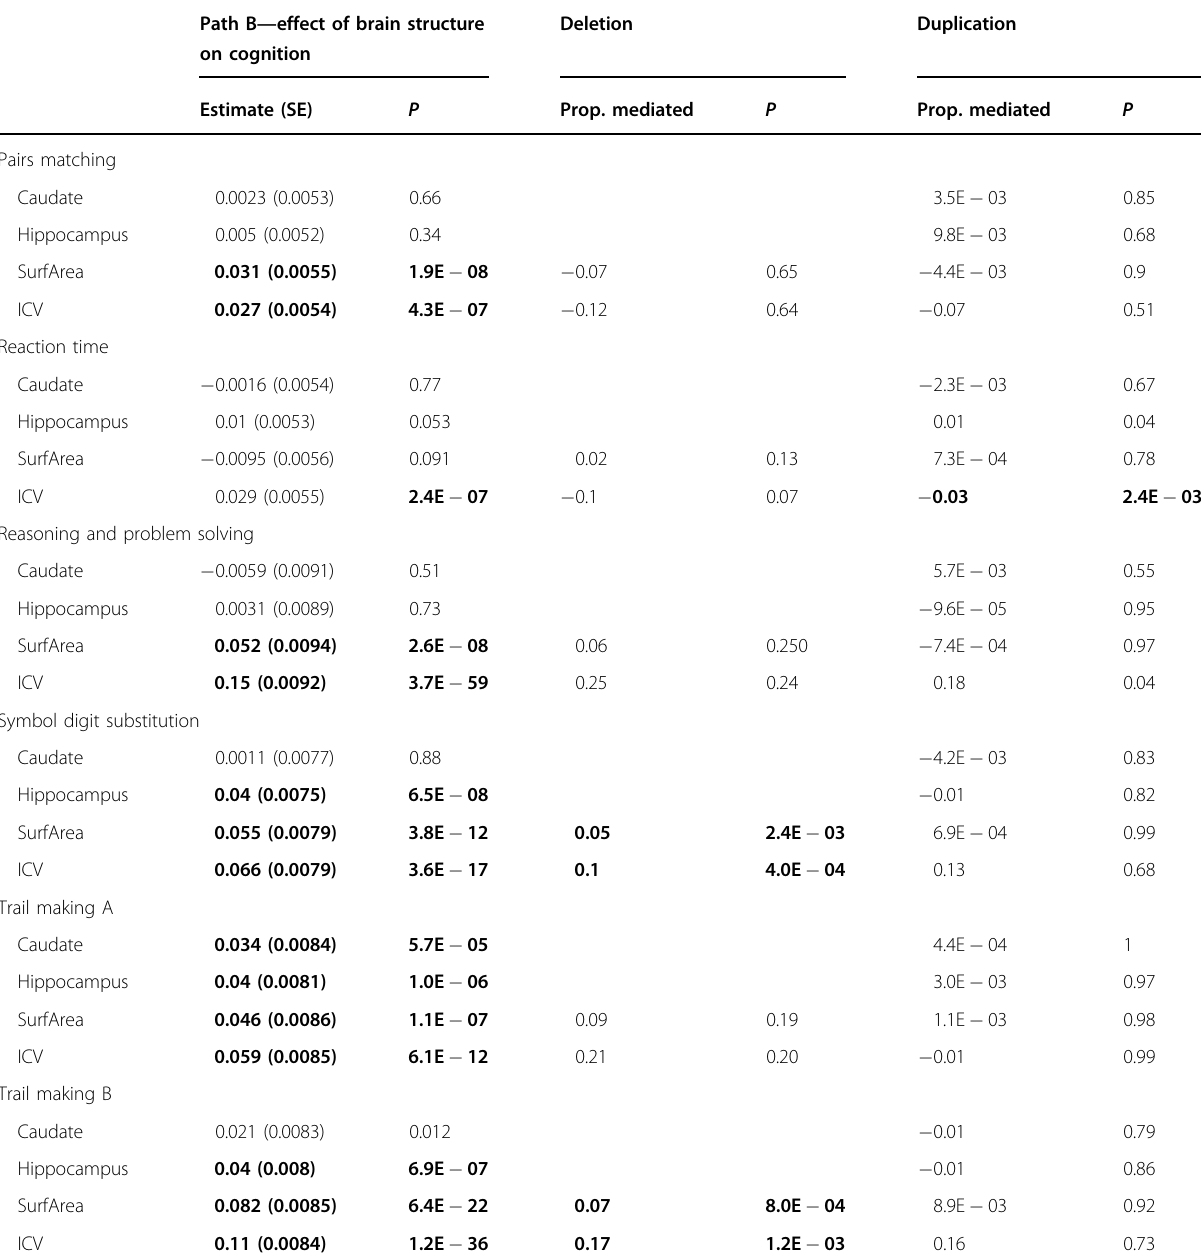
Table 3 Mediation analysis of brain structures over the association between 1q21.1 distal CNV carrier status and performance in the cognitive tasks in the UK